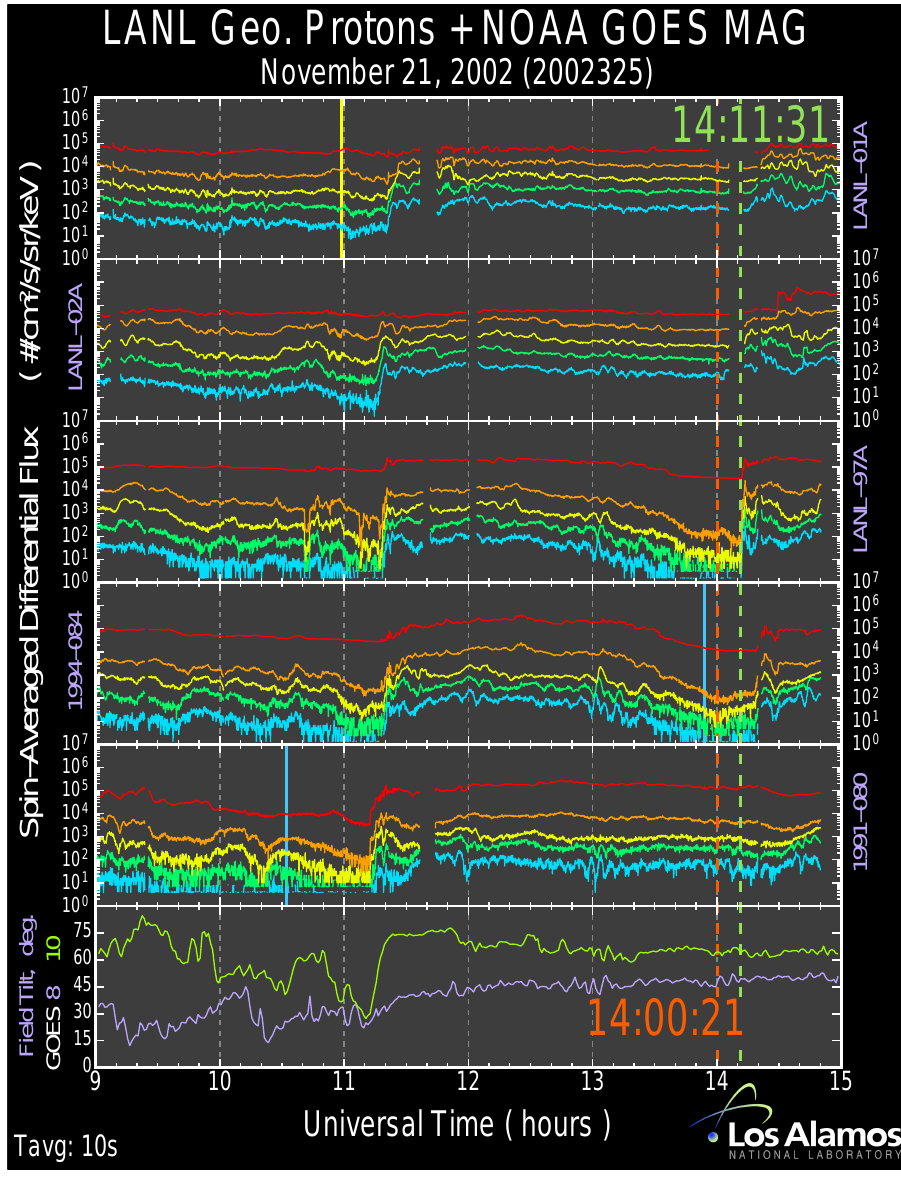
Fig. 4. Energetic proton data from the Los Alamos National Laboratory (LANL) Synchronous Orbit Particle Analyzer (SOPA) instruments. The time at which each satellite crossed local magnetic midnight (noon) is marked with a blue (yellow) line if the crossing occurred in the time range